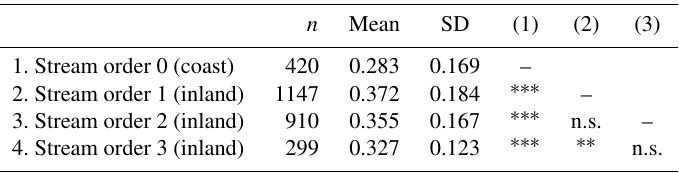
Table A5. Summary statistics and pairwise comparisons of how MAI-500 (the model agreement index of GFPLAIN, GAR-500, and JRC- 500) varies with different river stream orders. A Kruskal–Wallis test showed that there is a significant difference in model agreement between the river stream orders ( H( 3 ) = 101, p < 0 . 001). The pairwise comparisons, for detecting significant differences between the stream orders, have been conducted using the Wilcoxon rank-sum test with continuity correction.